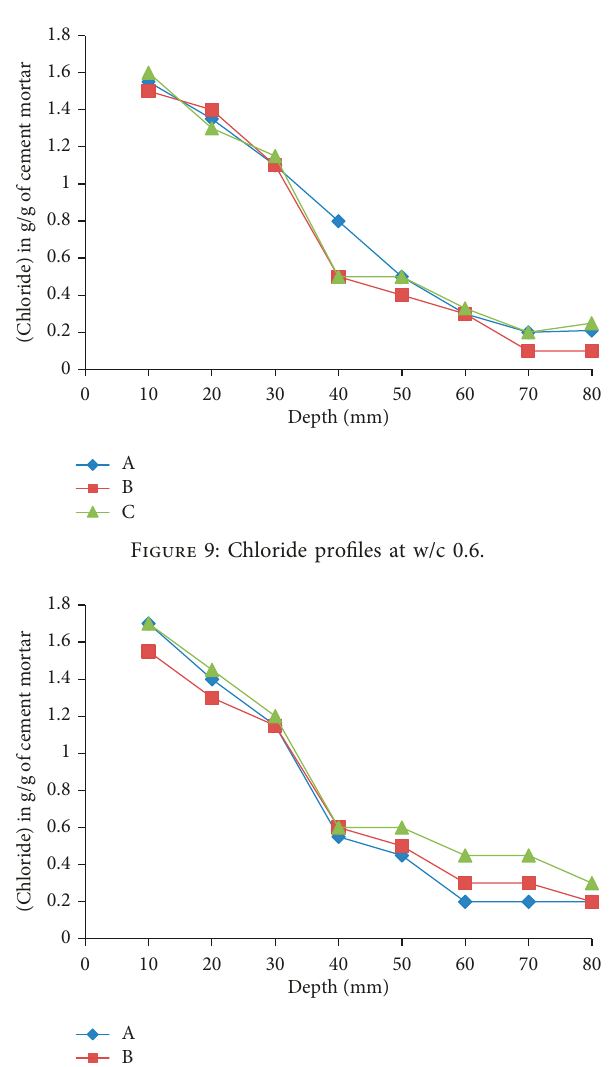
Figure 8: Chloride profiles at w/c 0.5.